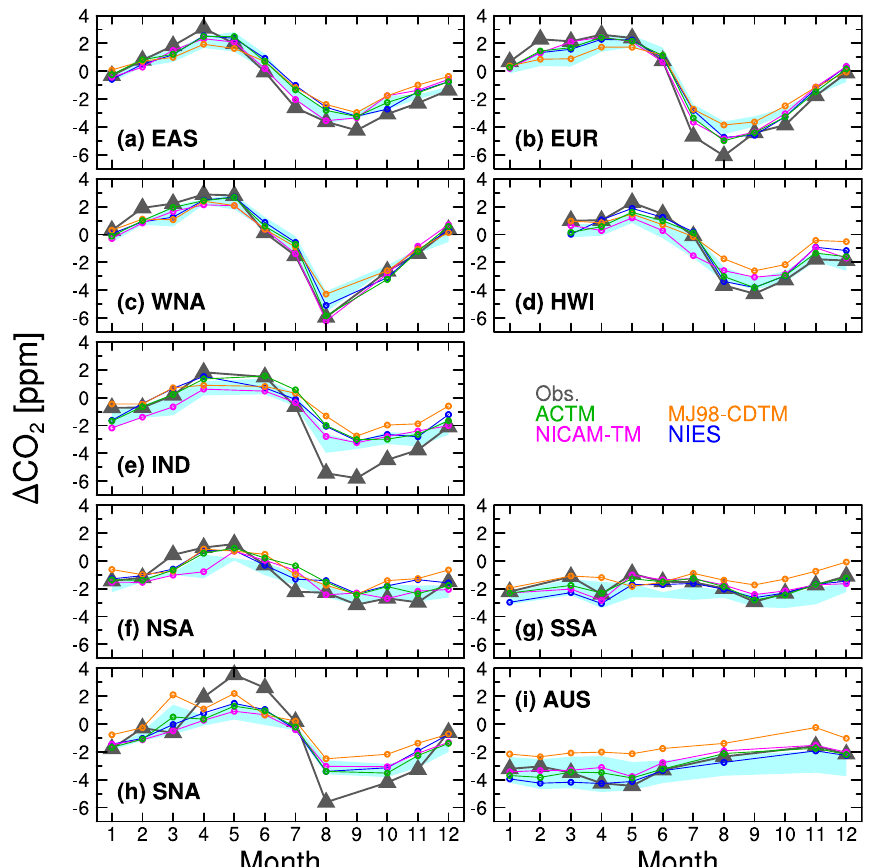
Fig. 6. Monthly mean variations of 1 CO 2 at 5–6km over each area for 2006–2007. Gray triangles with lines show the values for the CONTRAIL measurements. Circles with lines are for simulated results from Flux2: ACTM (green), MJ98-CDTM (orange), NICAM-TM (magenta), and NIES (blue). Cyan shade shows range of the simulated results from